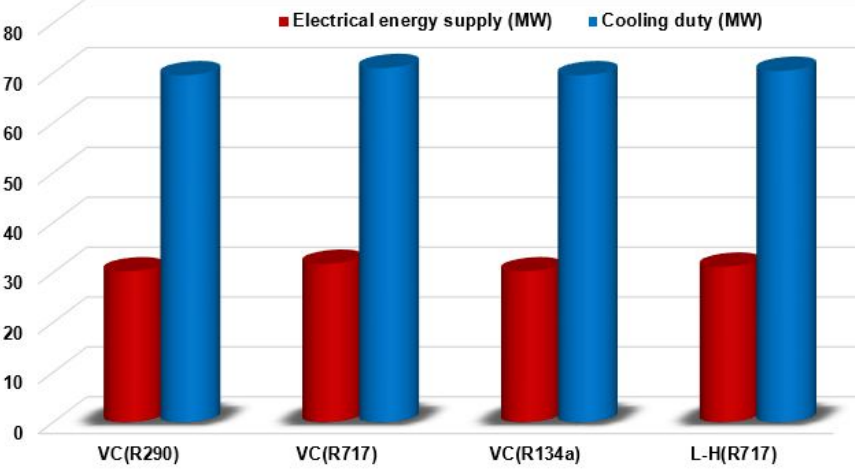
Figure 6. Comparison based on energy analysis.